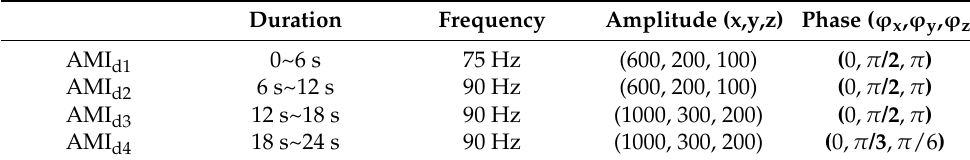
Table 3. The frequencies are different for the AMI d1 and AMI d2 : the AMI d2 and AMI d3 are different in amplitude, whereas, the AMI d3 and AMI d4 are different in phase. Table 3. Simulation values for dynamic AMI (AMI d